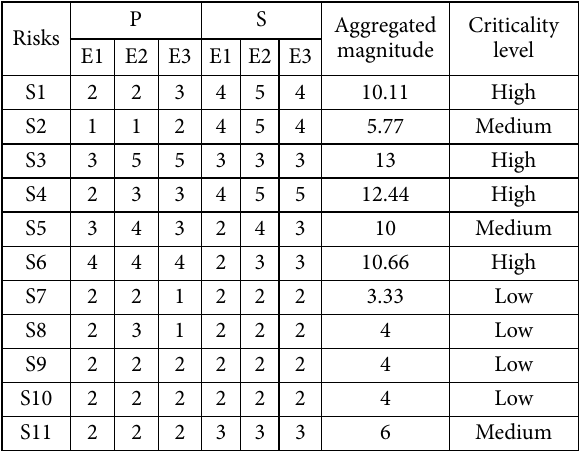
Table 9. The results of practical risk assessment approach Risks